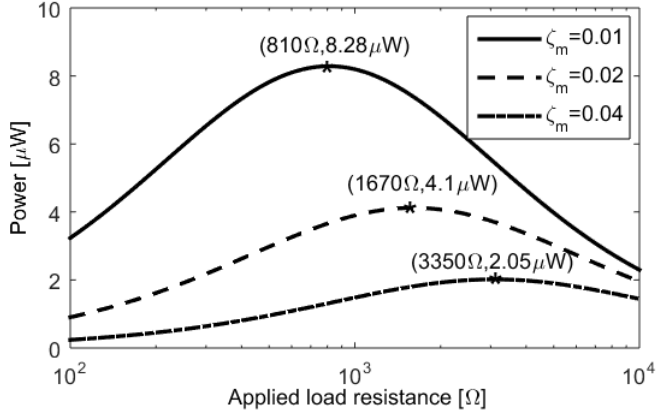
Figure 10. Output power at different mechanical damping ratios [ R op_res P max = (810 Ω × 8.28 μ W) = (1670 Ω × 4.1 μ W) = (3350 Ω × 2.05 μ W)].